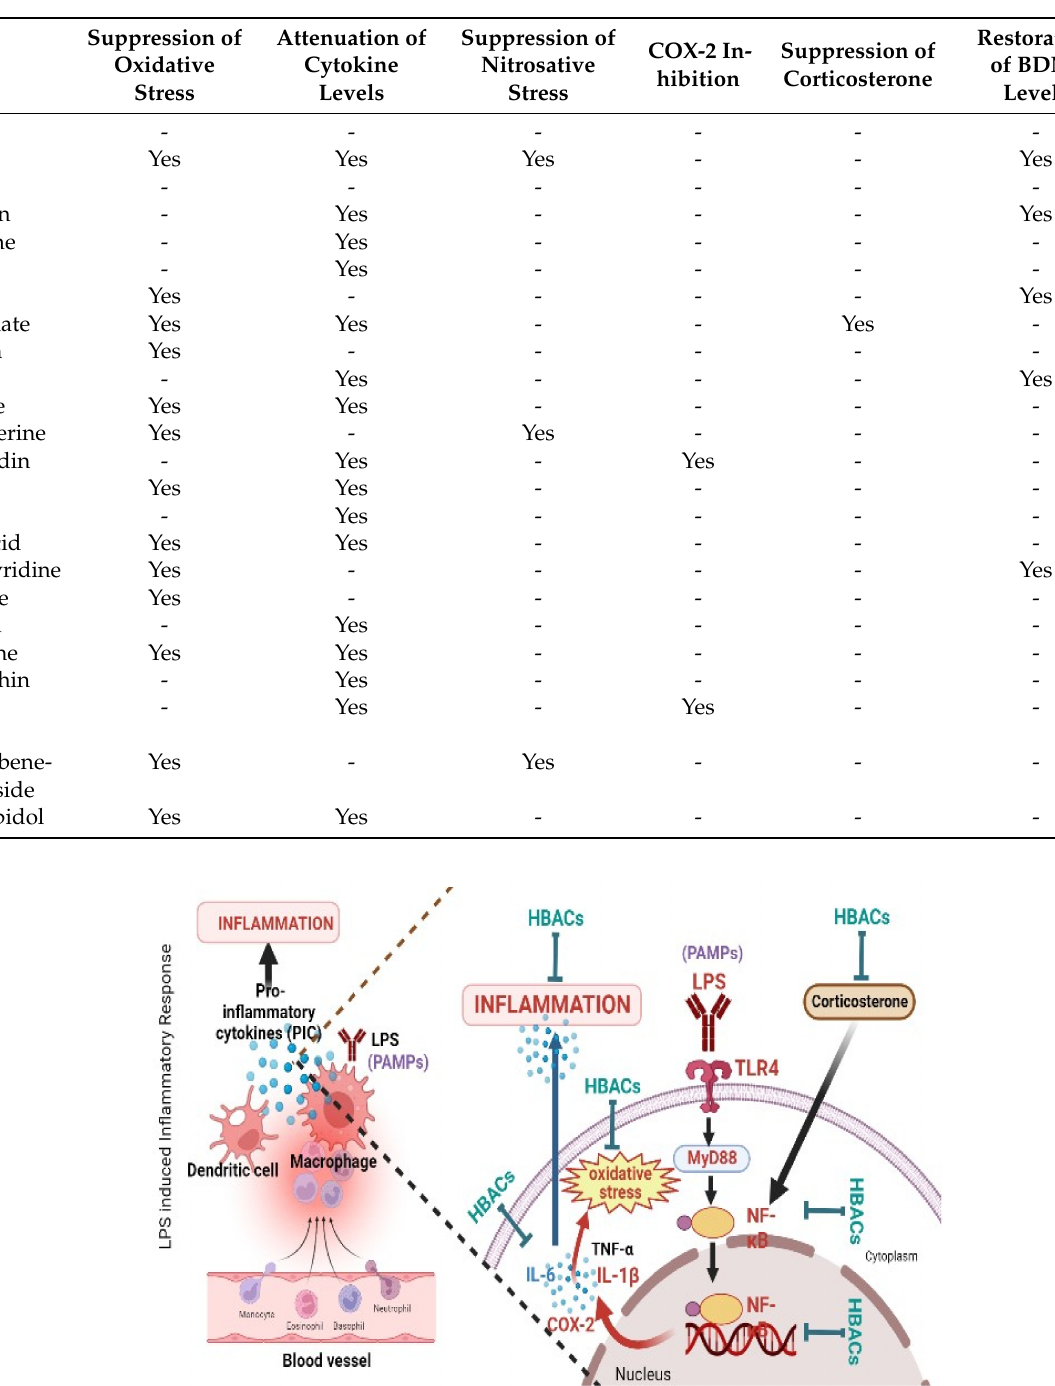
Figure 7. Molecular mechanism of action(s) of HBACs against LPS-induced sickness behaviour in rodents. PAMPs: pathogen-associated molecular patterns, TLR4: Toll-like receptor 4; IL-1 β : interleukin-1 β ; IL-6: interleukin-6; TNF- α : tumour necrosis factor- α ; and COX-2: cyclooxygenase-2. Figure created with the help of